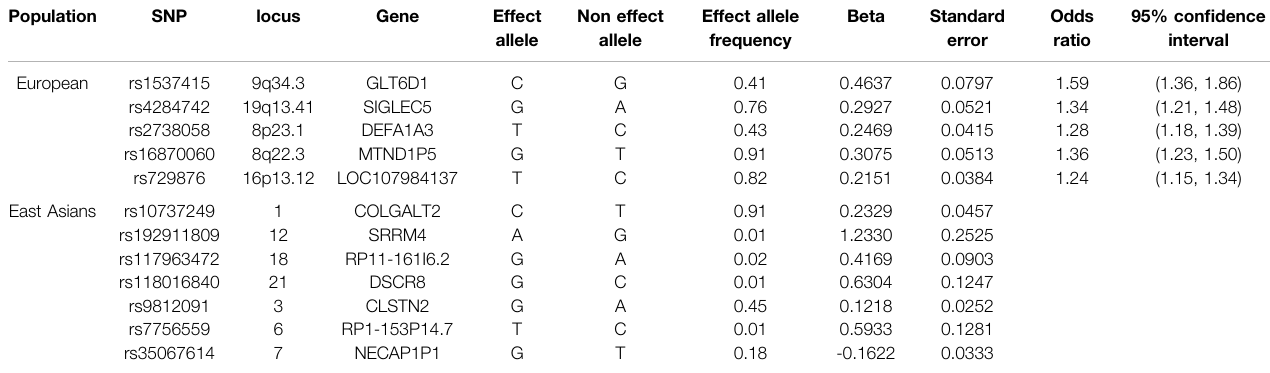
Table 1 | Characteristics of the SNPs predicting liability to periodontitis selected as instrumental variables for the Mendelian randomization analysis in Europeans and East Asians. Population SNP locus Gene Effect